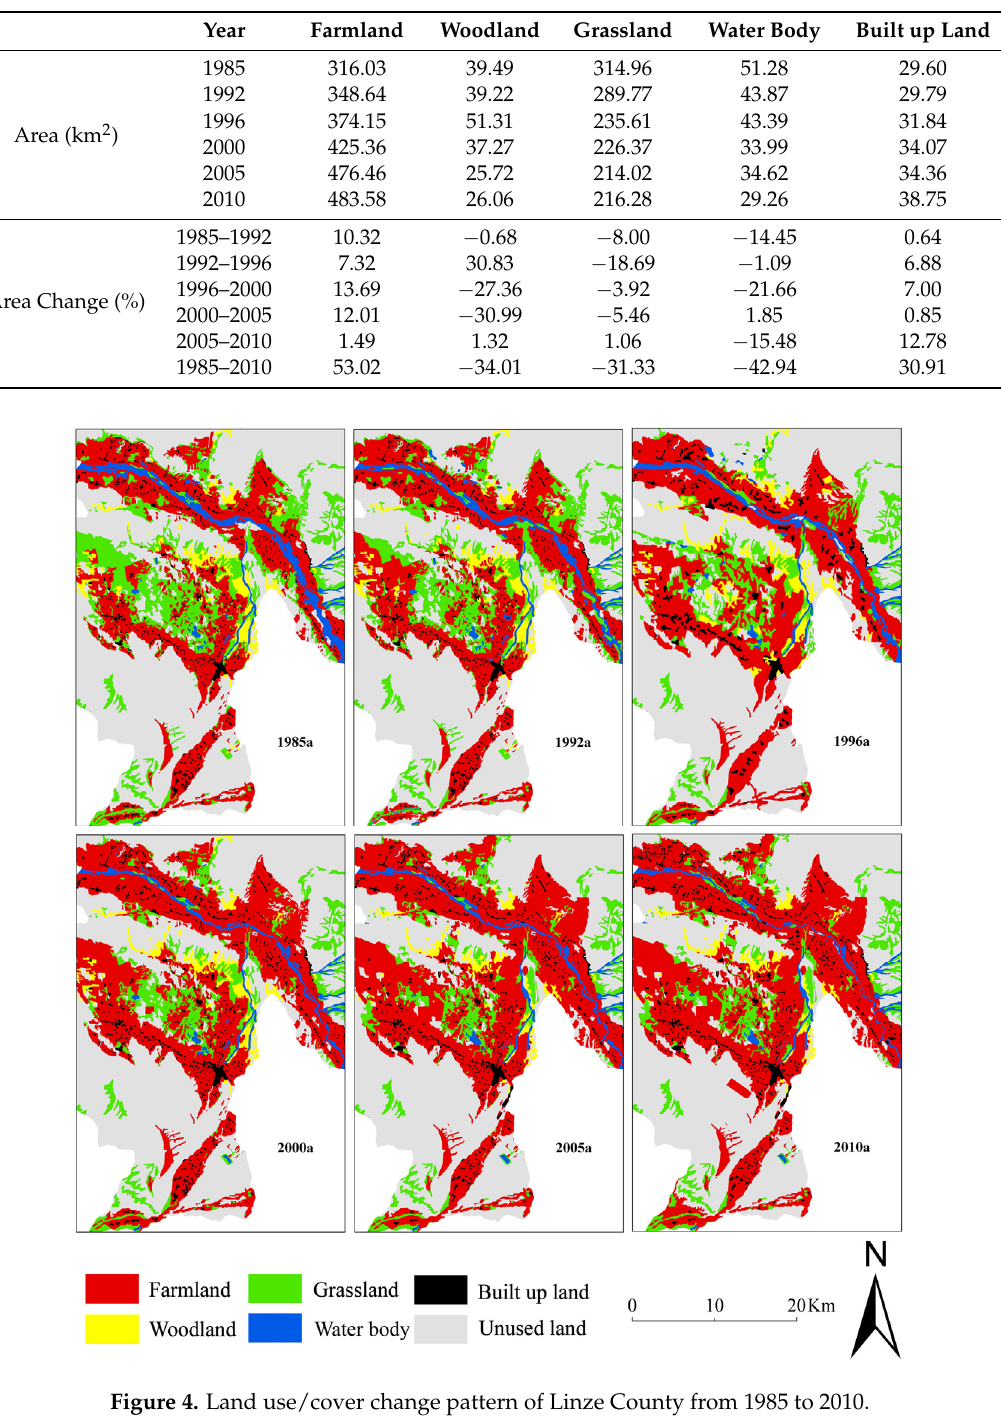
Figure 4. Land use/cover change pattern of Linze County from 1985 to 2010.